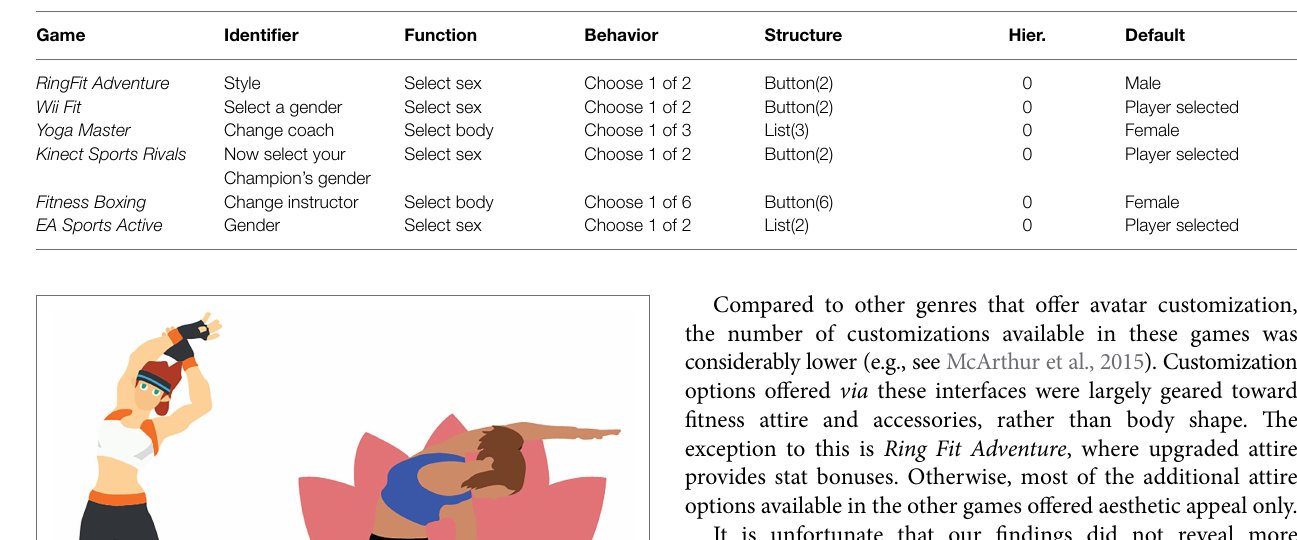
TABLE 1 | Avatar affordances data for Gender.